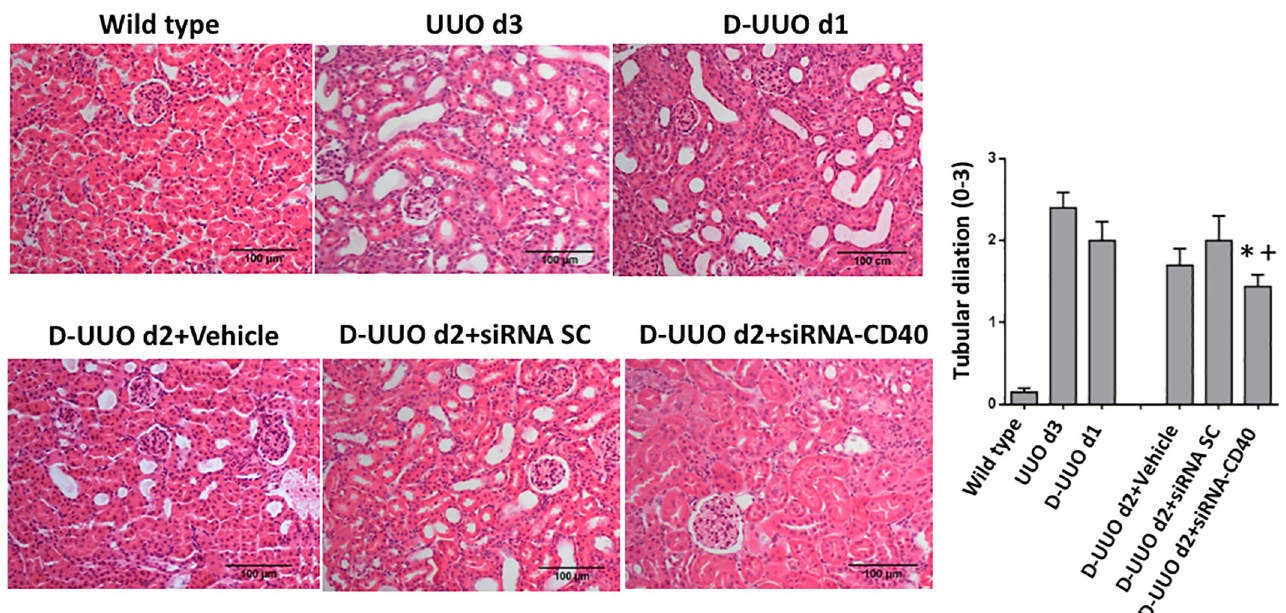
Fig 3. Tubulo-interstitial damage evaluation of the obstructed kidneys. Representative images of Haematoxylin & Eosin (H&E) staining. Original magnification 100x. Graphical quantification of H&E from each group using tubular dilation analysis. Chi-squared test; the values represent the mean ± SE, � p � 0.05 vs D-UUO d2, + p � 0.05 vs D-UUO d2+siRNA SC.